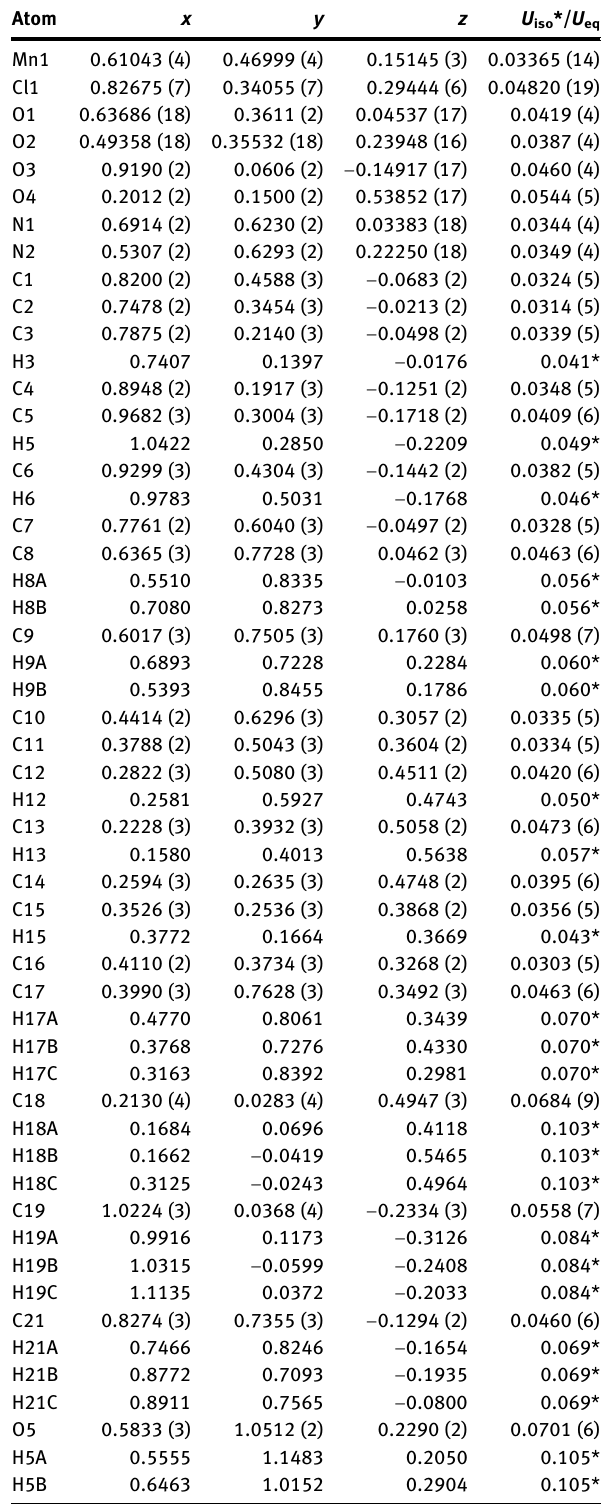
Table  : Fractional atomic coordinates and isotropic or equivalent isotropic displacement parameters (Å 